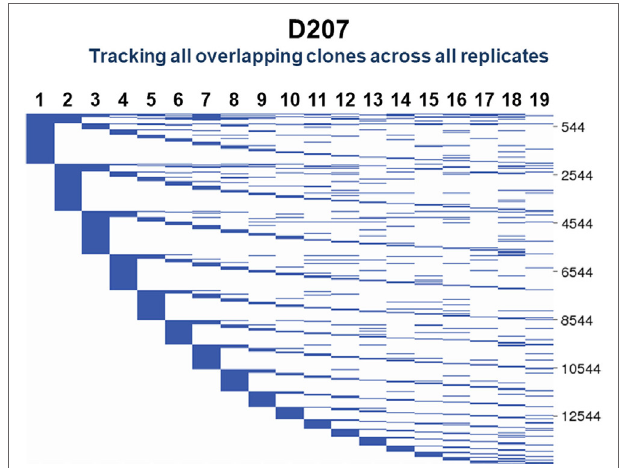
FIgUrE 9 | Tracking of shared clones across replicates in D207. All clones that were found in two or more replicates are shown. Each column is a replicate. Each horizontal line is a clone. The numbers of shared clones are given on the scale to the